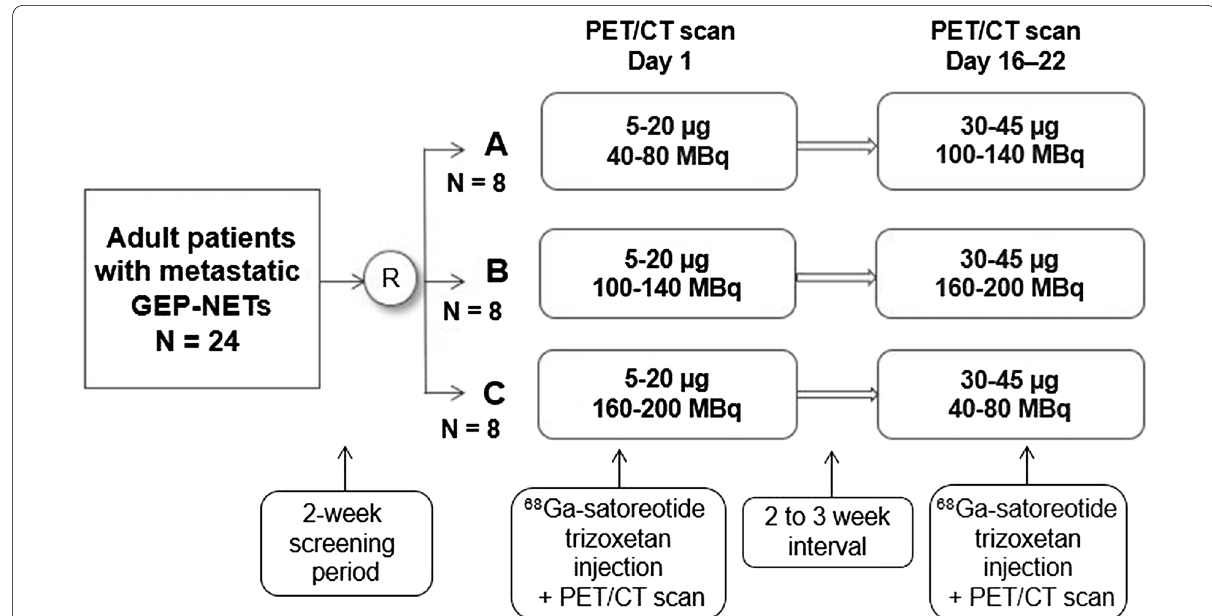
Fig. 1 Study design. Abbreviations: CT, computed tomography; GEP, gastroenteropancreatic; NET, neuroendocrine tumour; PET, positron emission tomography; R,